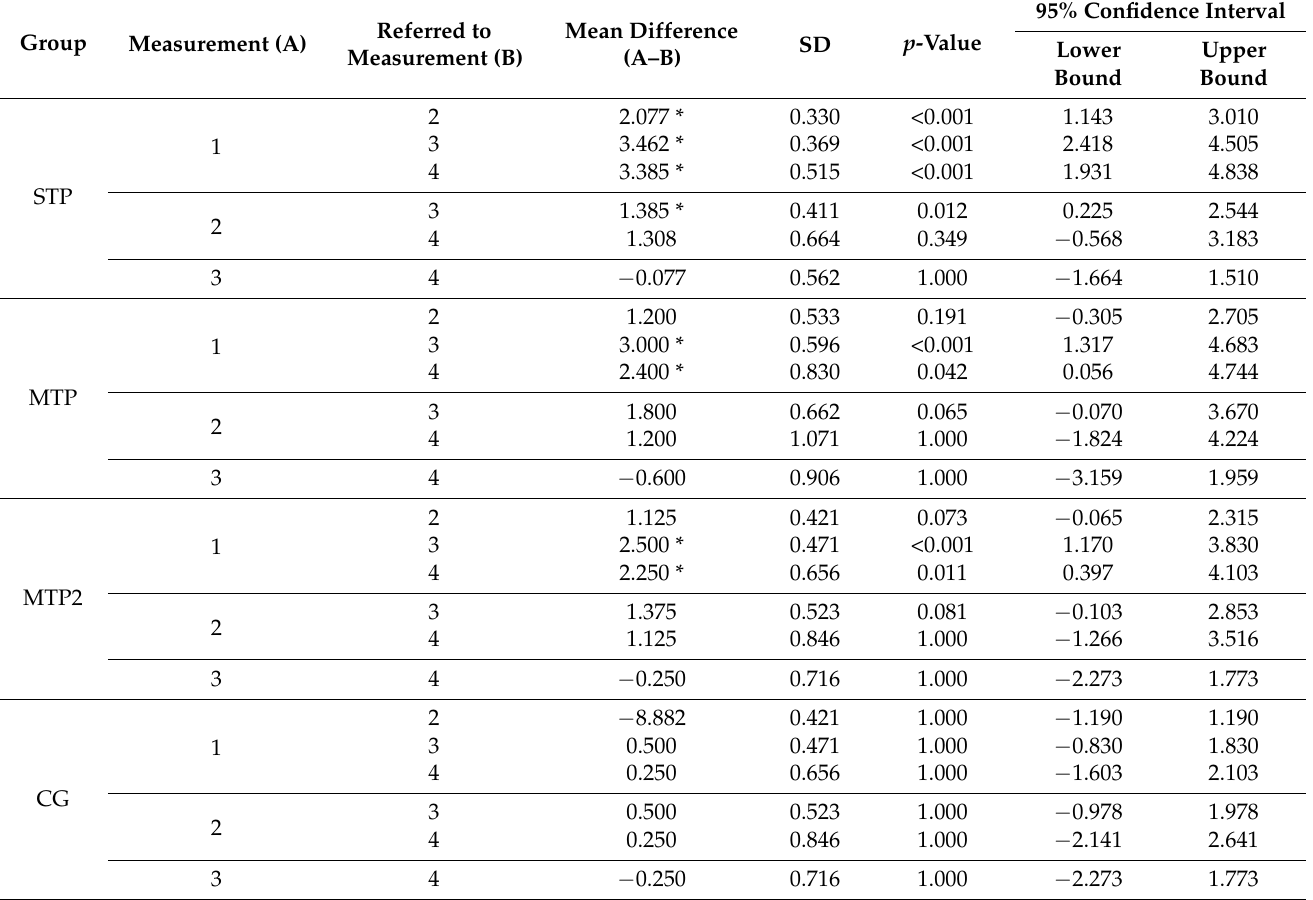
Table 3. Mean VAS differences between measurements in particular groups based on Tukey’s test